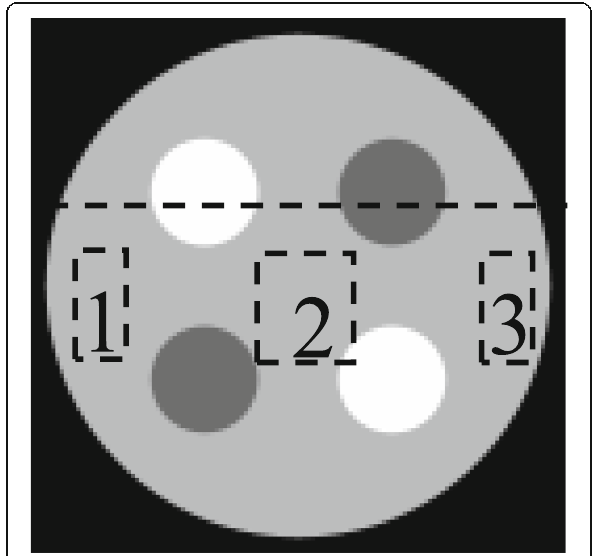
Fig. 1 Computer simulated phantom. The dotted horizontal line indicates the location of line-profiles. Regions 1, 2, and 3 were used for TV-norm evaluation